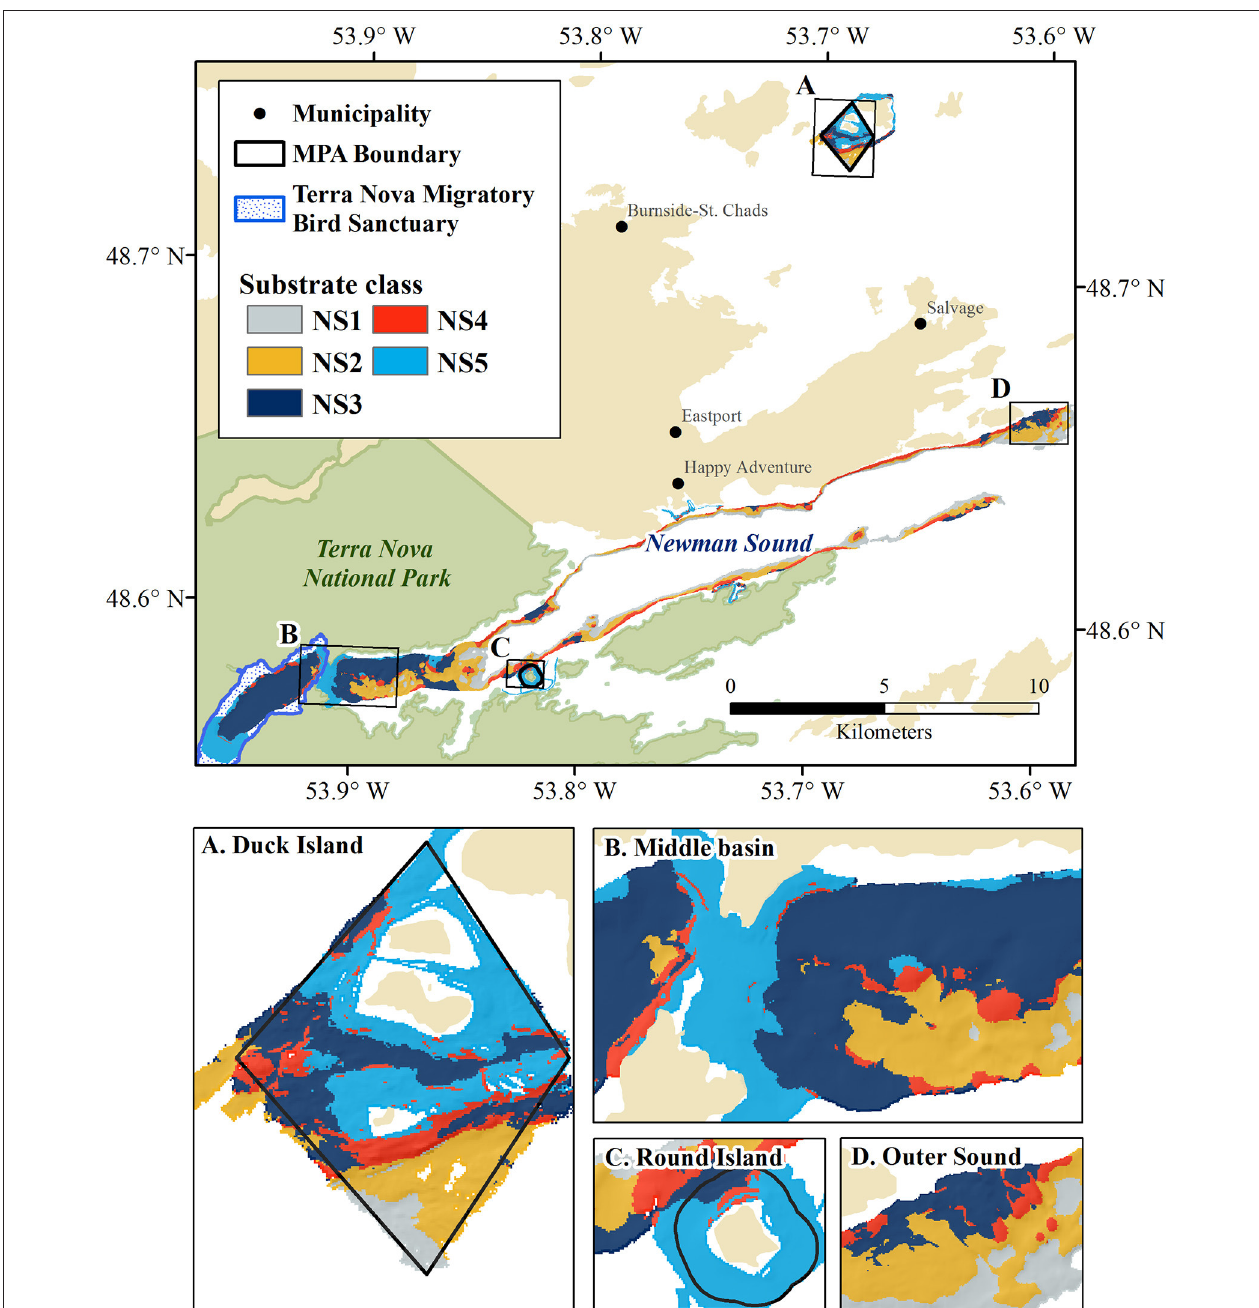
FIGURE 9 | Unsupervised substrate classification of Newman Sound and the Eastport MPA at 10m resolution. MPA closures and features of interest shown in insets: (A) Duck Island Closure, (B) Middle Basin narrows and shallow sill, (C) Round Island Closure, (D) Outer Sound fjord mouth.